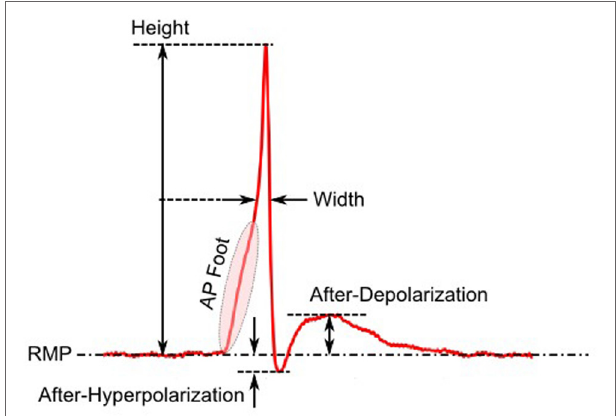
FIgURe 2 | Parameters employed for quantification of AP